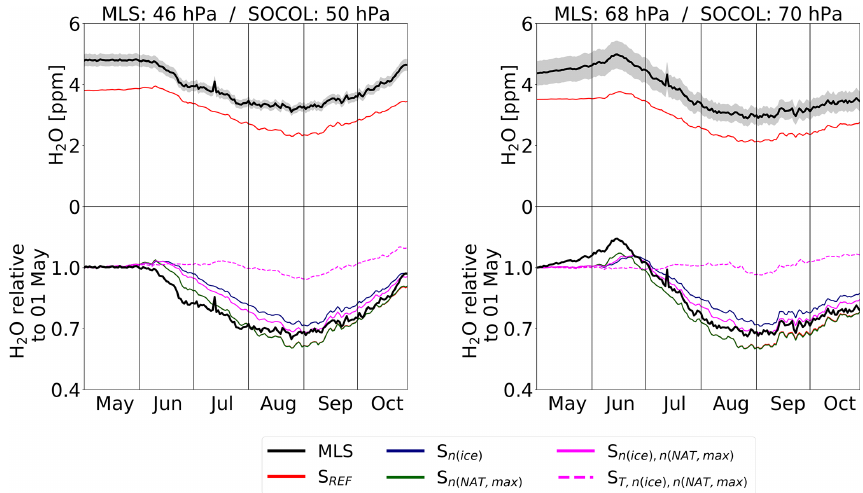
Figure 8. Same as Fig. 7, but for H 2 O. Note that the line of S n( NAT , max ) overlays S REF , since these simulations have identical H 2